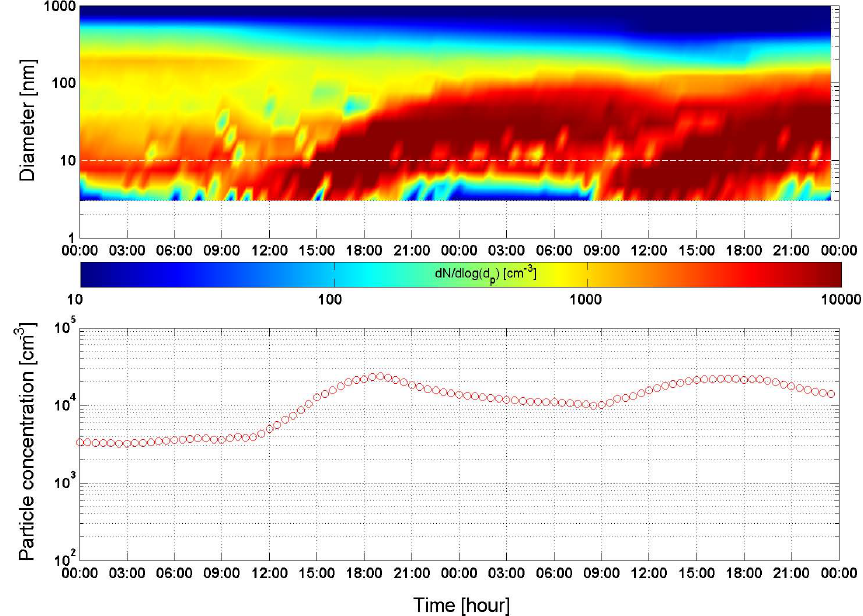
Fig. 2. Modeled evolution of the size distribution during the particle formation event using the particle formation scheme including both sulphuric acid and organics (Eq. 2), and a 30% secondary organics yield. Total particle number concentration at the lower panel is for the size range